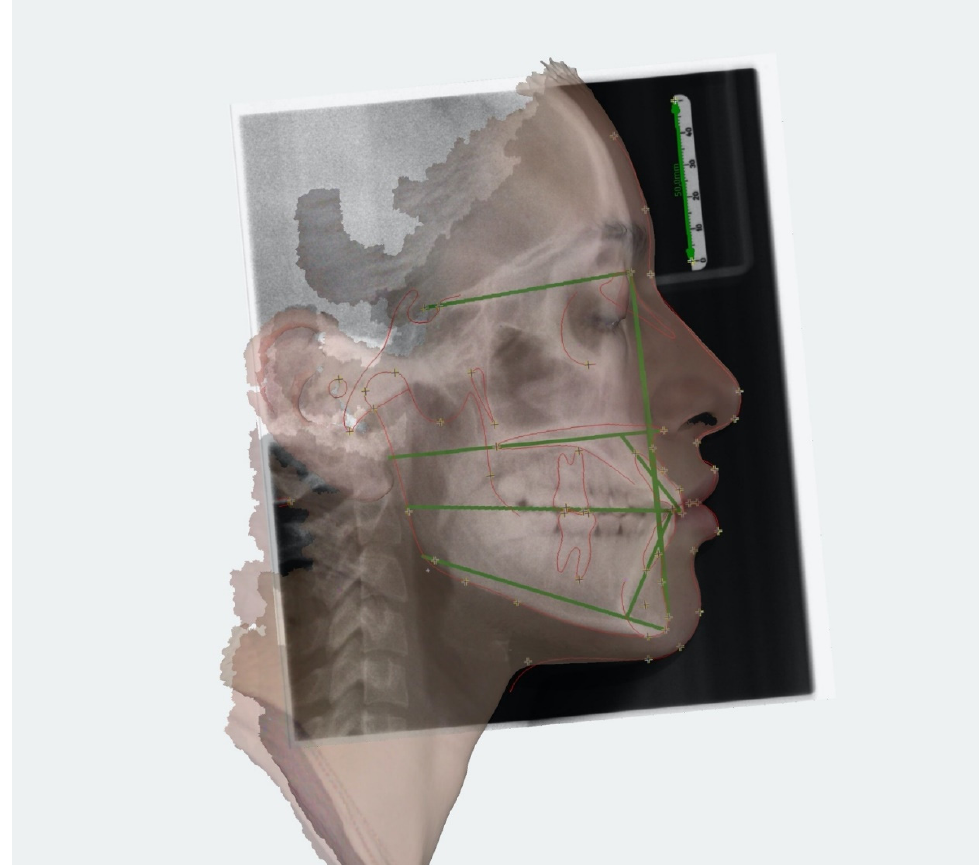
Figure 11. Face scan with virtual faceblow, position of condyles, and cephalometric landmarks.